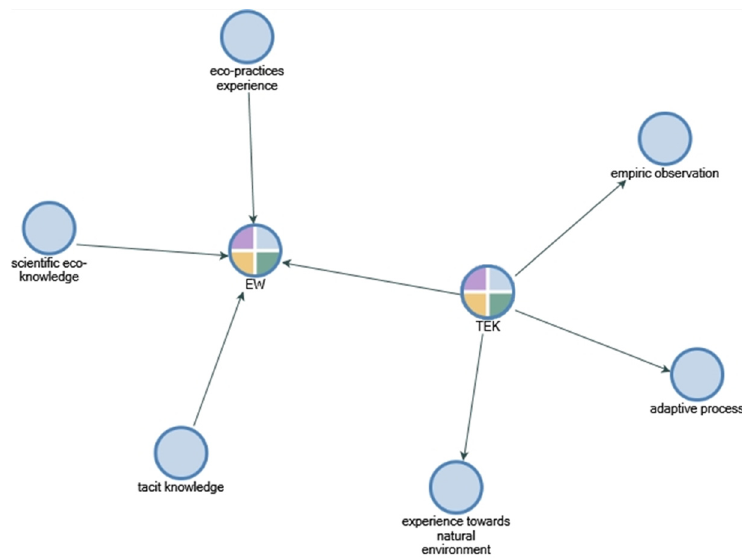
Figure 7. The connection diagram of sources between TEK and EW.